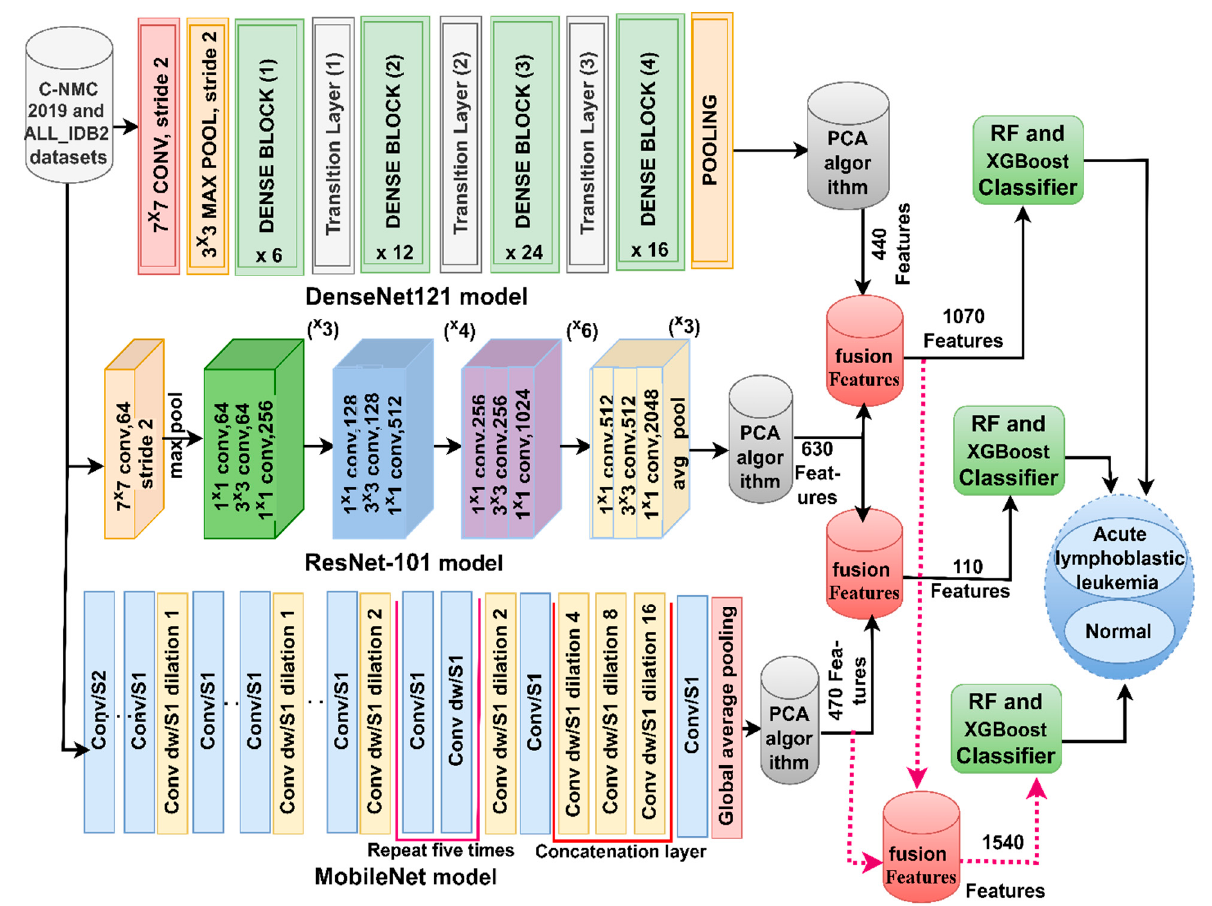
Figure 6. Hybrid technique framework based on hybrid CNN features for the diagnosis of ALL.